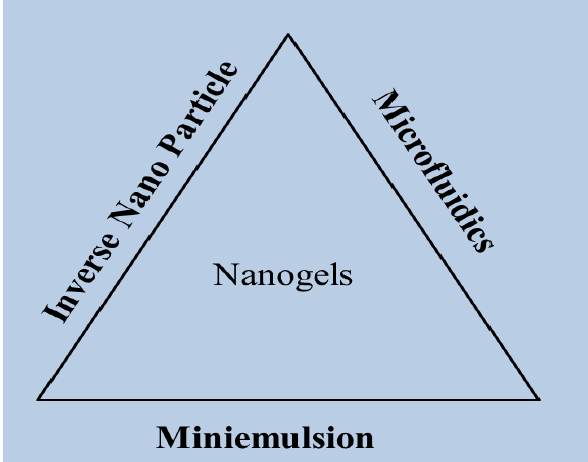
Figure 1. Different methods of nanogel preparation.